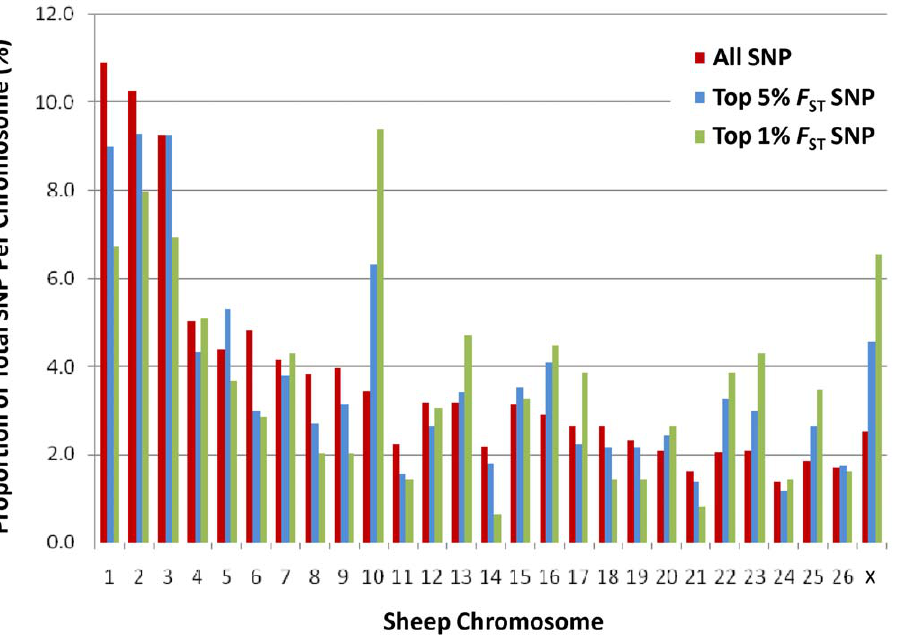
Figure 3. Distribution of divergent SNP across the sheep chromosome. The degree of divergence between the Florida and Louisiana Native populations was estimated for each SNP as F ST . The genomic distribution of SNP with extreme values (either the top 1% or 5% of ranked values) is shown as a function of their chromosomal location. This revealed an over representation of high F ST SNP on chromosome 10 when compared to the proportion expected.